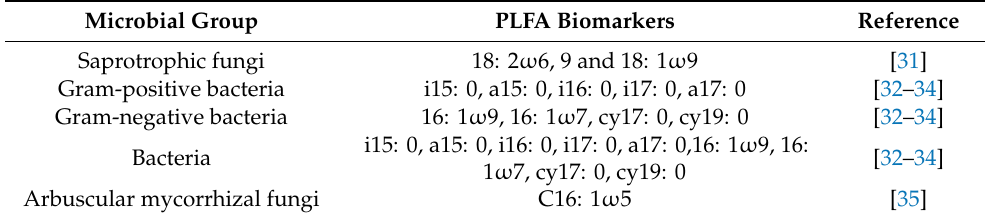
Table 2. Phospholipid fatty acids (PLFA) biomarkers for calculating soil microbial biomass. Microbial Group PLFA Biomarkers